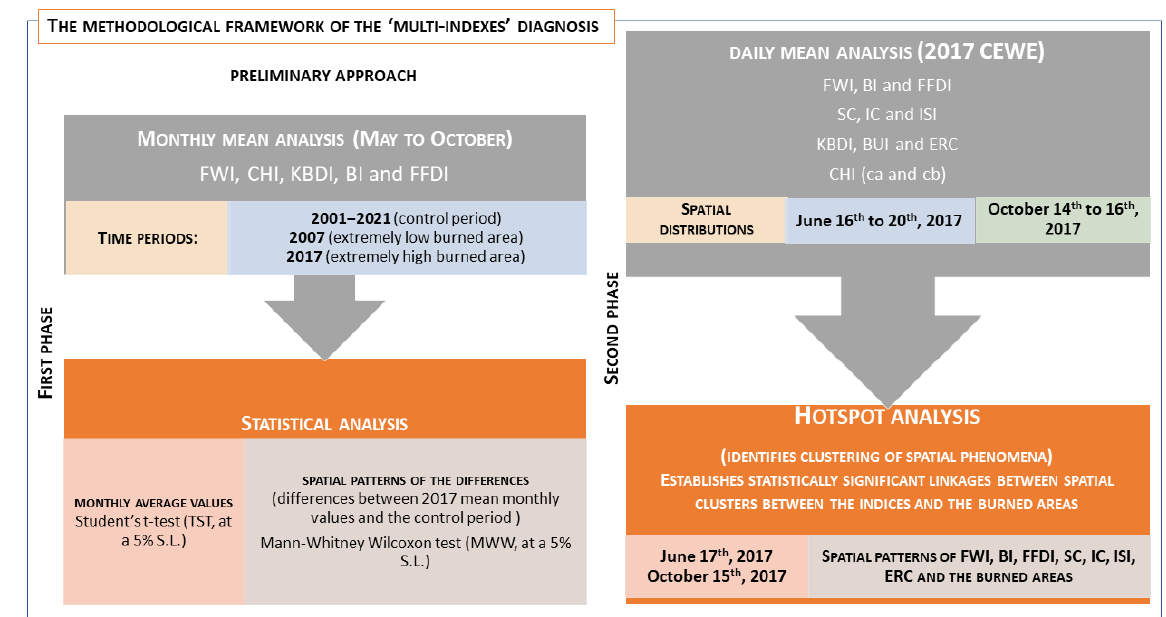
Figure 1. The methodological framework of this study.